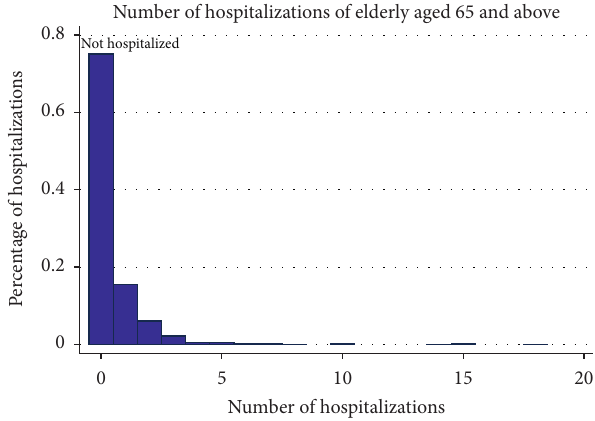
Figure 1: The number of